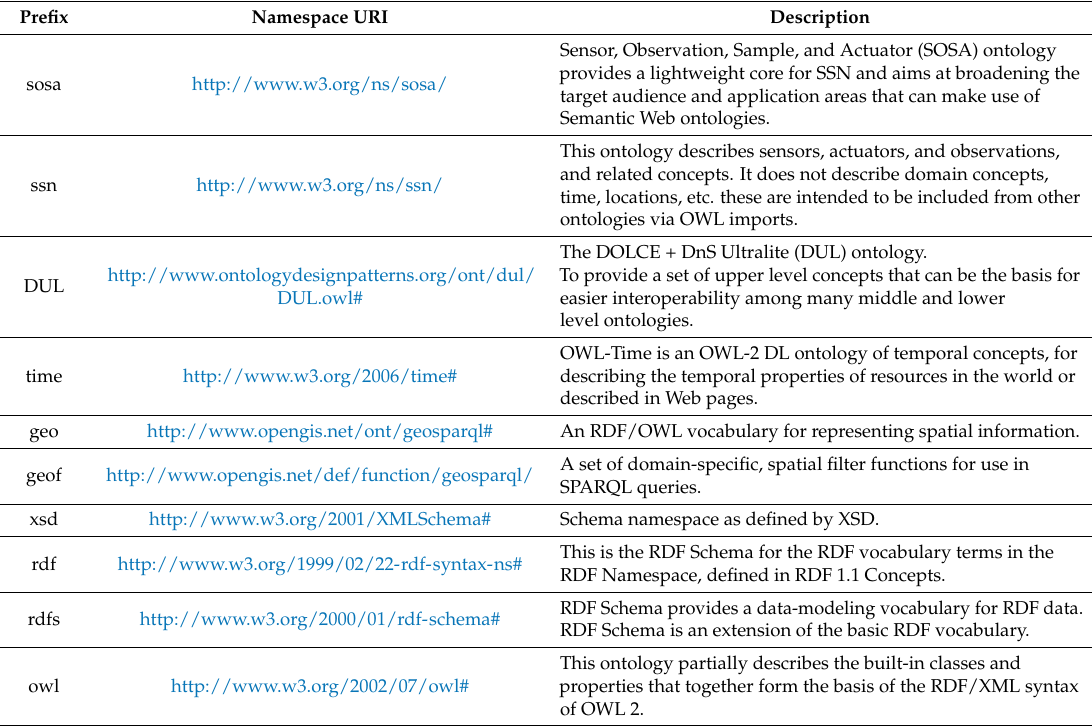
Table 1. The namespaces involved in the proposed hydrological sensor web